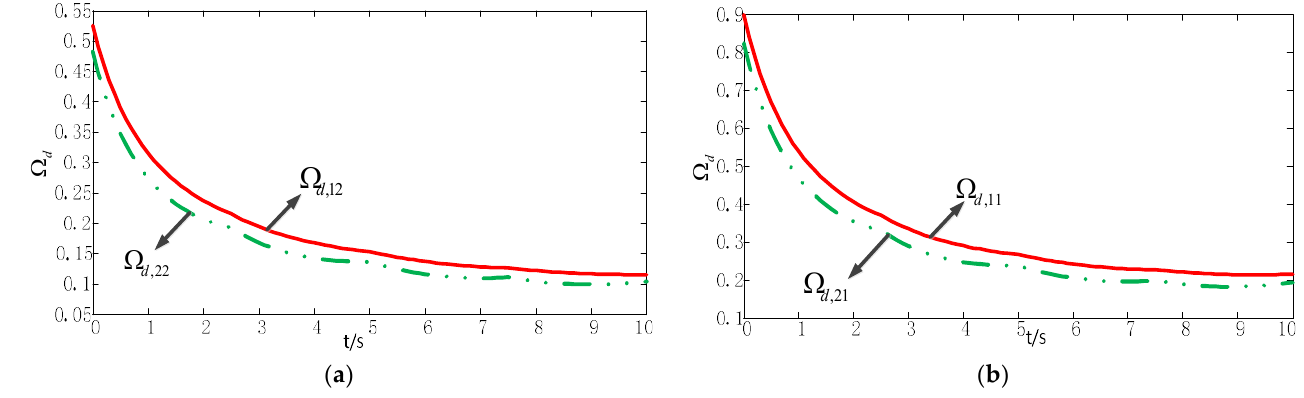
Figure 5. Comparison of the stability along the given spatial spiral trajectory when s = 1, 2, t = 1 and s = 1, 2, t = 2: ( a ) comparison of the stability with s = 1, t = 2 and s = 2, t = 2; ( b ) comparison of the stability with s = 1, t = 1 and s = 2, t = 1.